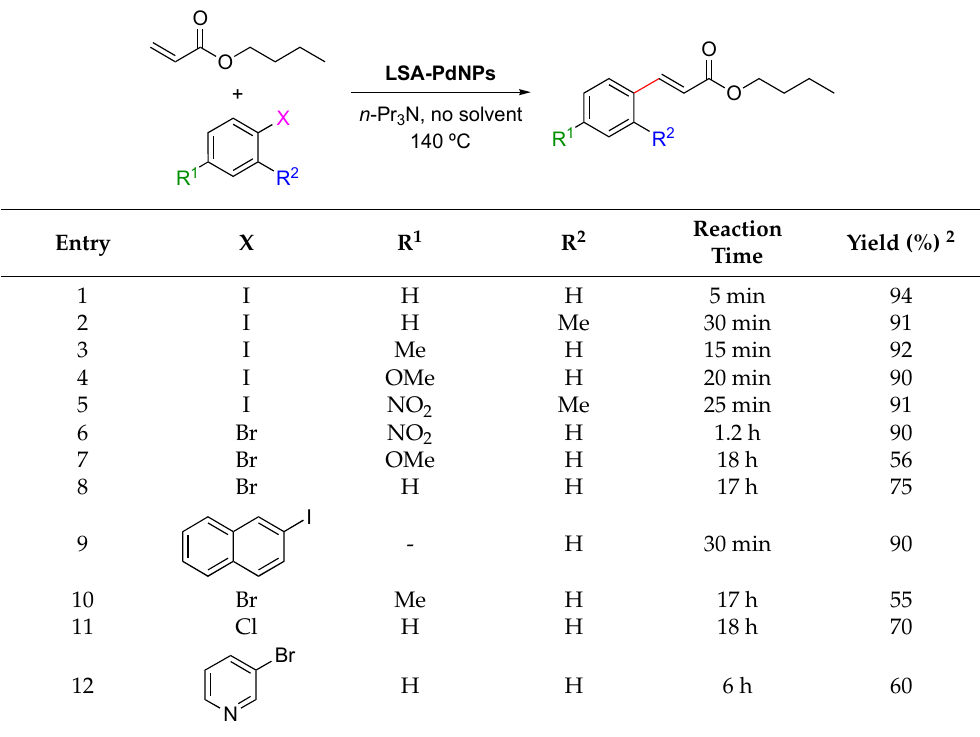
Table 9. LSA-PdNPs catalyzed the Heck reaction between n -butyl acrylate and aryl halides [61] 1 .